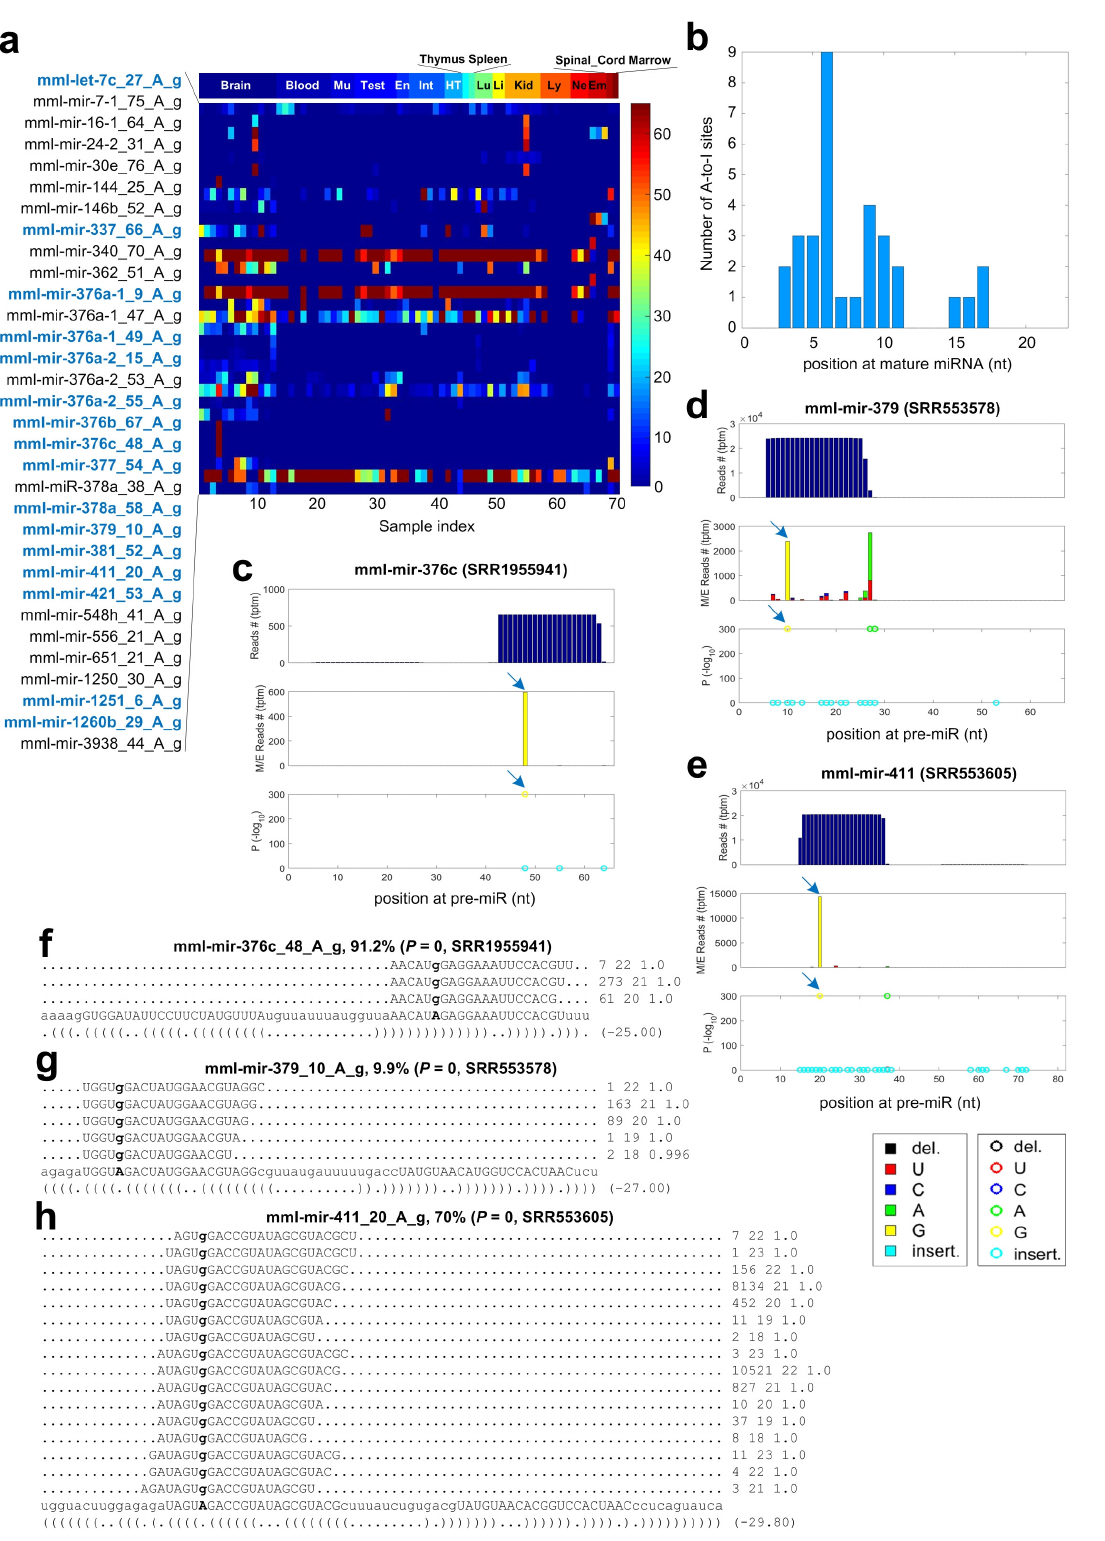
Figure 4. The details of 32 A-to-I editing sites identified in miRNAs of Macaca mulatta . ( a ) The editing levels of the 32 A-to-I editing sites in the 70 selected sRNA-seq profiles. The Sample Index of the x-axis is the same as serial in Table S7. The tissues from left to right are Brain, Blood, Muscle (Mu), Testis